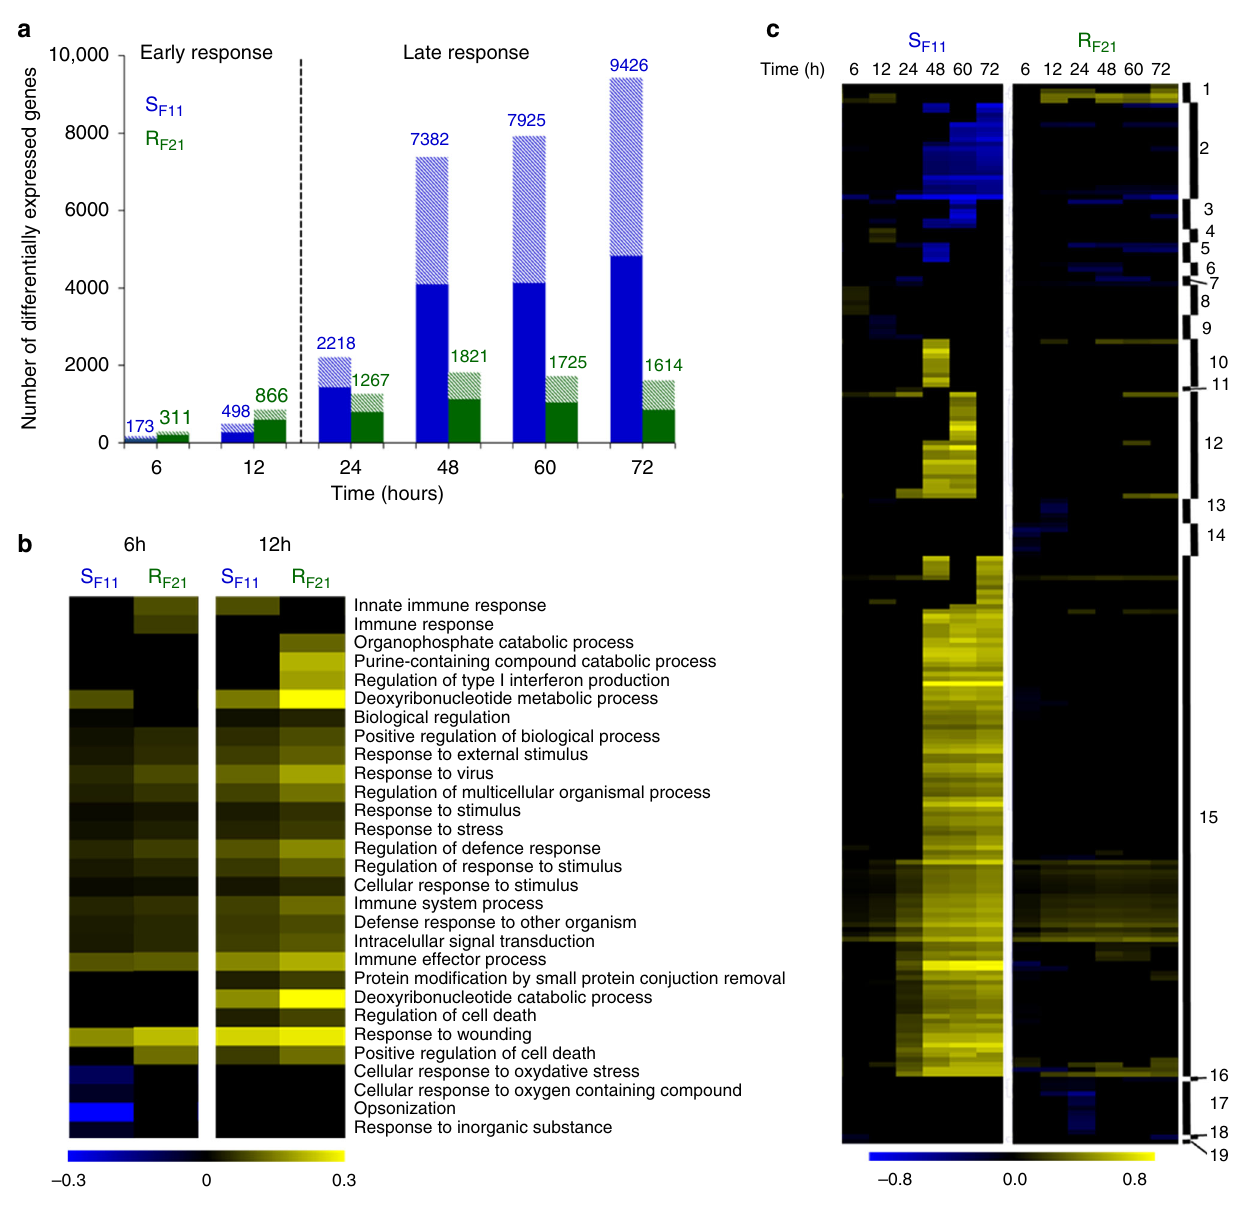
Fig. 5 The resistant R F21 oysters display an early antiviral response that is delayed in the S F11 susceptible oysters. a The number of genes that were differentially expressed during the ‘ natural ’ experimental infection was higher in R F21 (green) than in S F11 (blue) oysters before 24 h (early response). This trend was reversed after 24 h and until the end of the infection (late response). Upregulated genes are represented as fi lled coloured bars and downregulated genes are represented as hatched bars. b Heatmap focusing on the two clusters containing 29 immune-related GO categories that were signi fi cantly enriched at 6 and 12 h (FDR < 1%; clusters A and B, Supplementary Fig. 10). c Heatmap of the 220 signi fi cantly enriched GO categories (FDR < 1%, biological processes root) clustered according to the Pearson correlation (numbered fi lled bar). The enrichment intensity was expressed as the ratio between the number of genes that were signi fi cantly up- (yellow heat) or downregulated (blue heat) in the category compared with the total number of genes in the category. If the intensity was equal to zero (black heat), then the enrichment was not signi fi cant for the corresponding condition. Detailed results (cluster number, GO terms and enrichment values) are presented in Supplementary Data